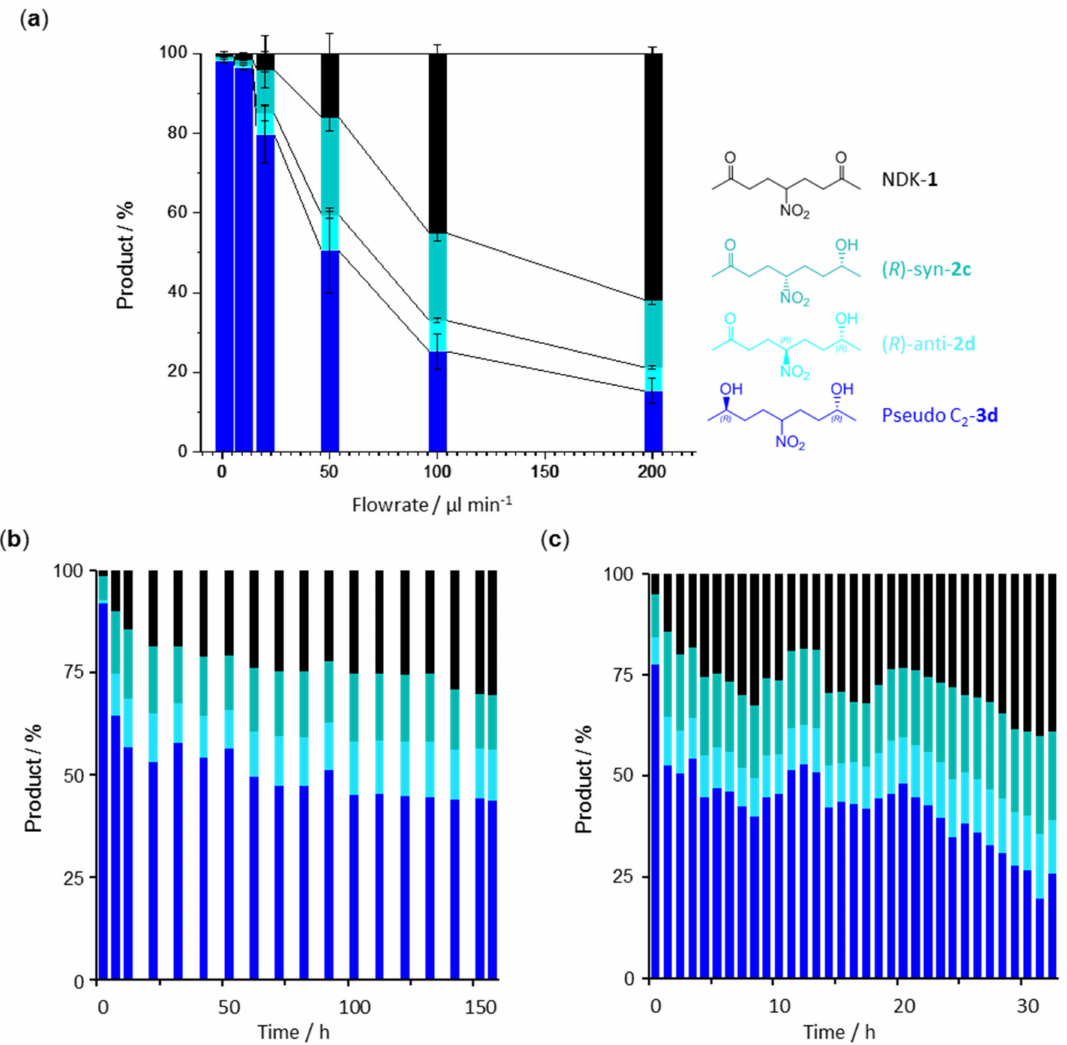
Figure 3. Product distributions determined in the outflow of reactor modules containing the LbADH–ST/GDH–SC hydrogel: ( a ) Flowrate dependency; ( b ) long-term time dependency with continuous NADP + -supply over >6 days (flowrate 10 µ L/min); ( c ) time dependency with encapsulated NADP + (flowrate 10 µ